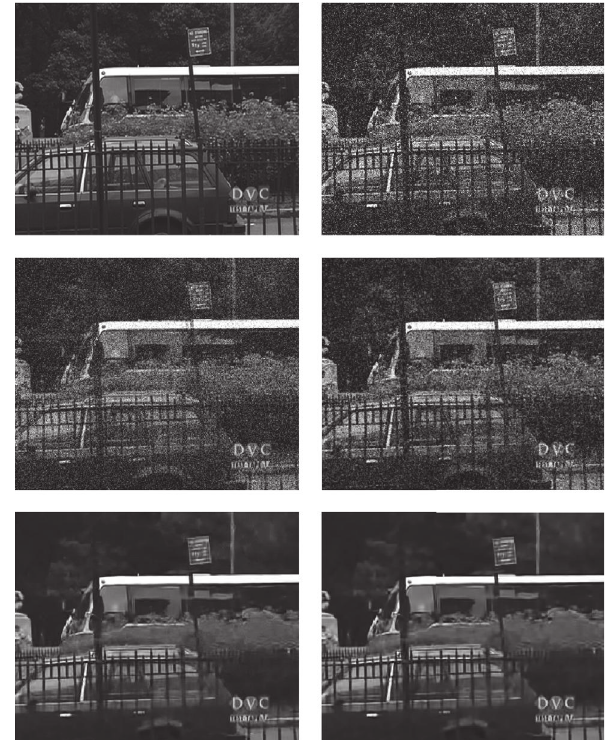
Figure 4: Visual comparison of different algorithms for frame 5 of Bus sequence. From left to right and from top to bottom: original frame, noisy frame ( 𝜎 𝑛 = 40 ), result of [18] algorithm, result of [19] algorithm, result of [13] algorithm, and result of the proposed algorithm.